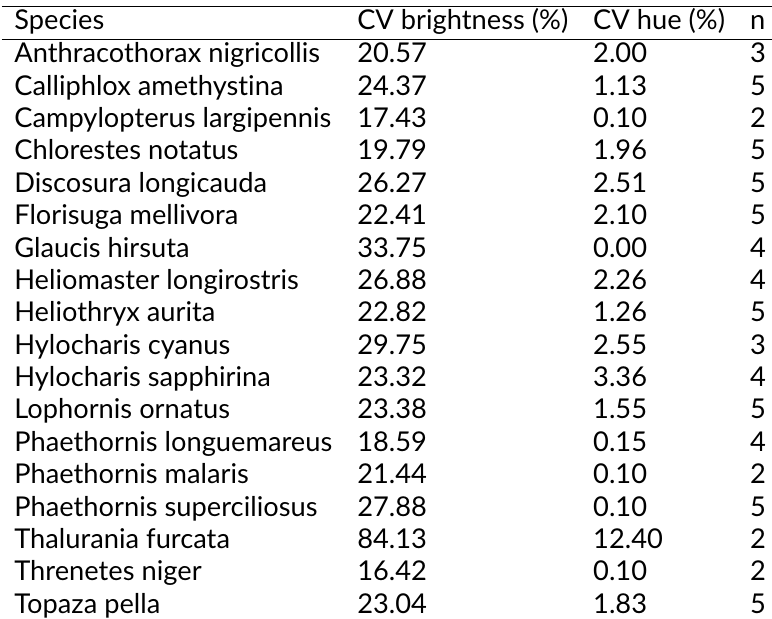
Table 4 – Measurement of intraspecific variability for brightness (B2) and hue (H1) by computing the coefficient of variation (standard deviation divided the average) on an independent dataset of hummingbirds living in French Guiana (Gomez et al , unpublished data), in which between 2 and 5 males (last column) were measured for each species. The measurement protocol differs slightly from the one used in this study, because we used a birfucated probe at 45 ° , which may increase the intraspecific variability in brightness. In spite of the apparently high values of the coefficient of variation for brightness, it remains highly repeatable as estimated by the intra-class coefficient (Nakagawa and Schielzeth, \def \blx@tempa {}2010): R = 0.809 , p < 0.0001 for brightness and R = 0.661 , p < 0.0001 for